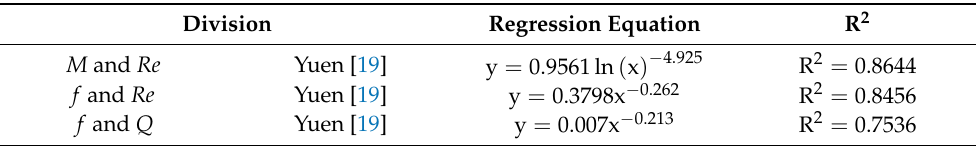
Table 3. The results for the relationship between M , f , Re , and Q using Babaeyan-Koopaei’s data. Division Regression Equation R 2 M and Re Babaeyan-Koopaei [20] y = 0.8846ln ( x ) − 0.379 R 2 =